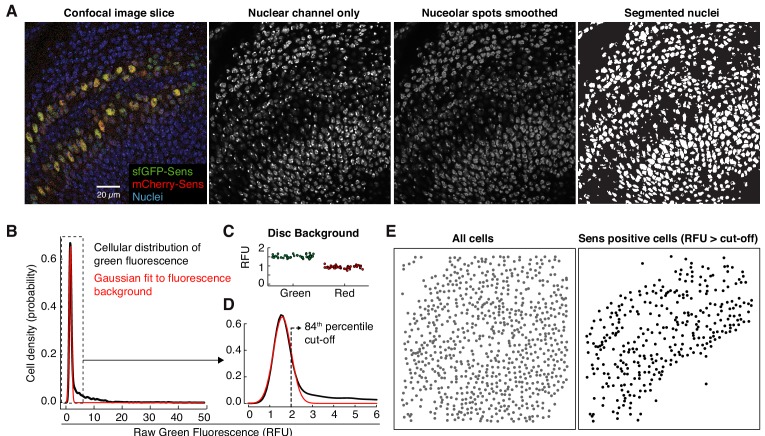
Image analysis of developing wing tissue to quantify Sens protein in single cells.(A) The nuclear (DAPI) channel from individual confocal image slices was used to computationally identify and segment individual nuclei. Average single cell sfGFP and mCherry fluorescence signals were then estimated from segmented nuclei. (B) Raw sfGFP signal (green fluorescence channel) histogram from the wing disc in (A) is shown as an example. The Gaussian-fitted fluorescence background is shown in red. (C) Mean fluorescence background was calculated for green or red channels in individual images. Each datapoint is one disc. (D) Magnified view of histogram in (B). Dashed line marks the cut-off signal value above which cells were considered Sens-positive. (E) Computationally identified Sens-positive cells displayed the expected expression pattern and were used for further analysis.